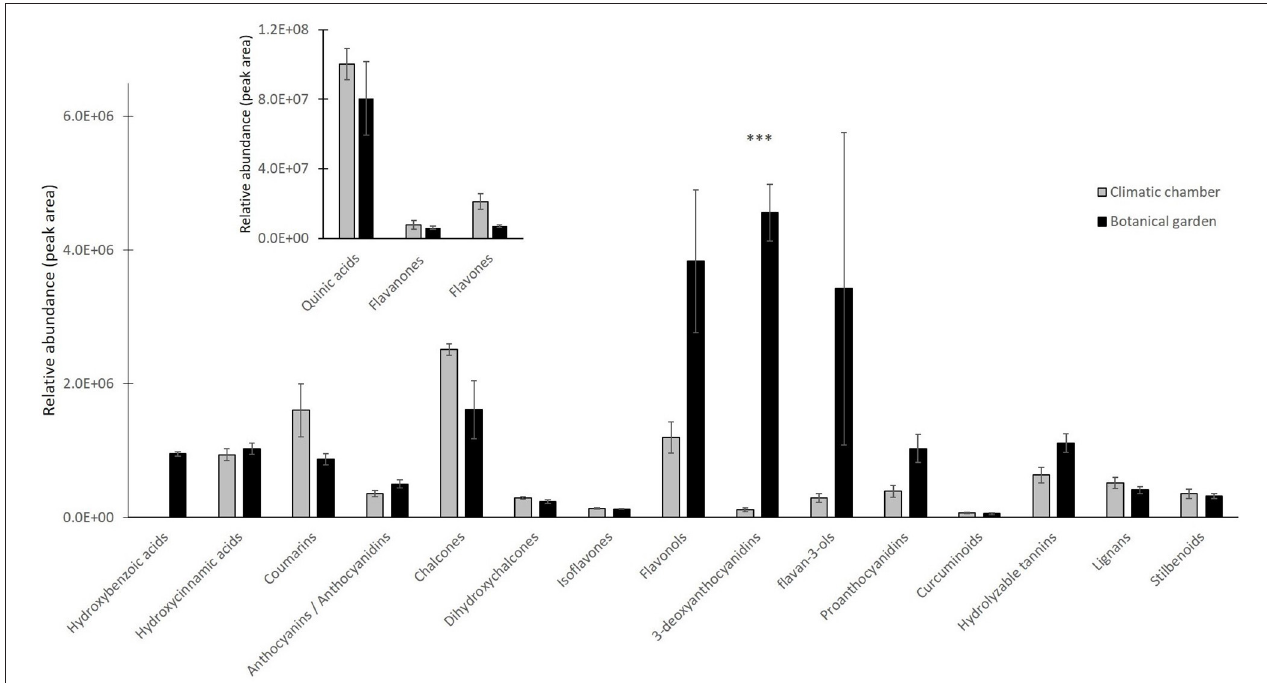
FIGURE 2 | Relative abundance of different subclasses of polyphenols detected by liquid chromatography coupled with high resolution mass spectrometry (LC/HRMS) analysis in CC (220 photosynthetic photon flux density (PPFD) of light intensity; 10-h photoperiod, 25/20 ◦ C day/night temperature) vs. BG samples. Quinic acid, flavanones, and flavones were reported in a different framed histogram with higher y-axis scale for better visualization. Data are mean ± standard error (SE) of six biological replicates. Asterisks indicate significant differences between treatments as determined by t -test for P <